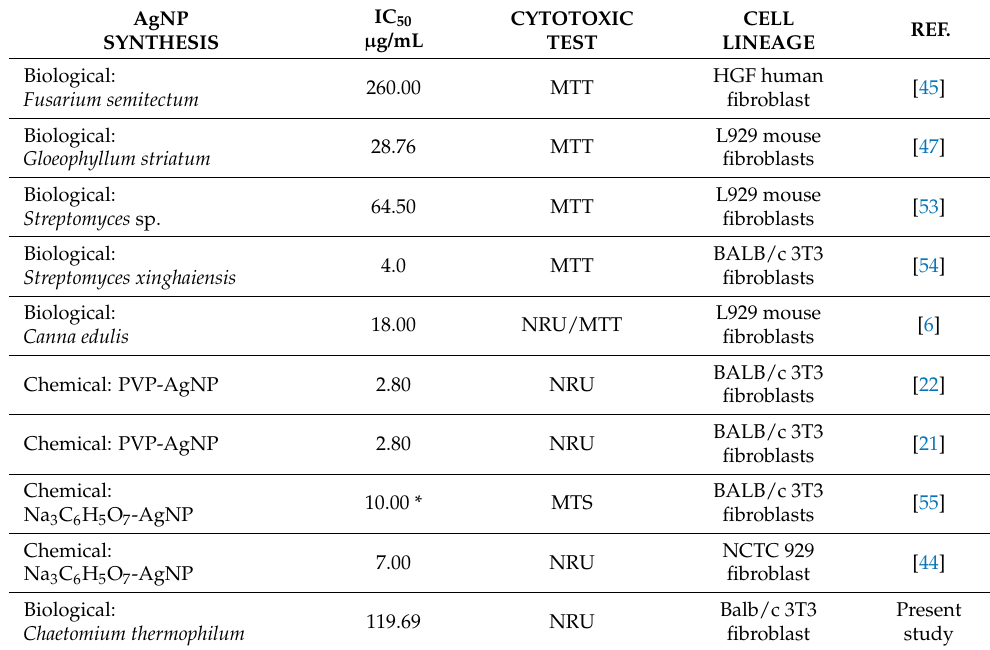
Table 2. Comparative IC 50 of AgNPs synthesised in different